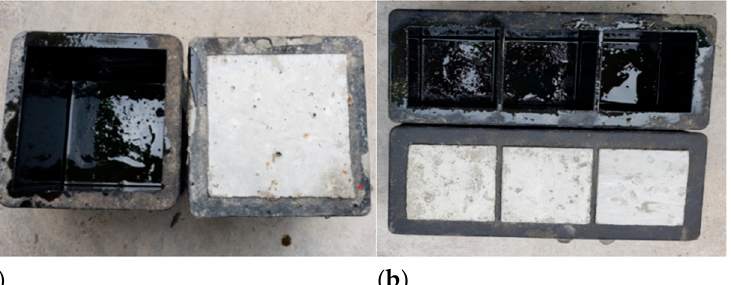
Figure 1. Test pieces of two sizes. ( a ) 150 mm × 150 mm × 150 mm cube. ( b ) 70.7 mm × 70.7 mm × 70.7 mm